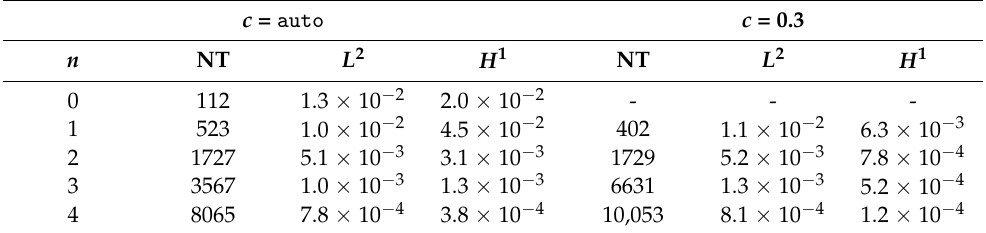
Table 2. L 2 and H 1 error for example 1 by using the gradient recovery error estimator. c = auto c =